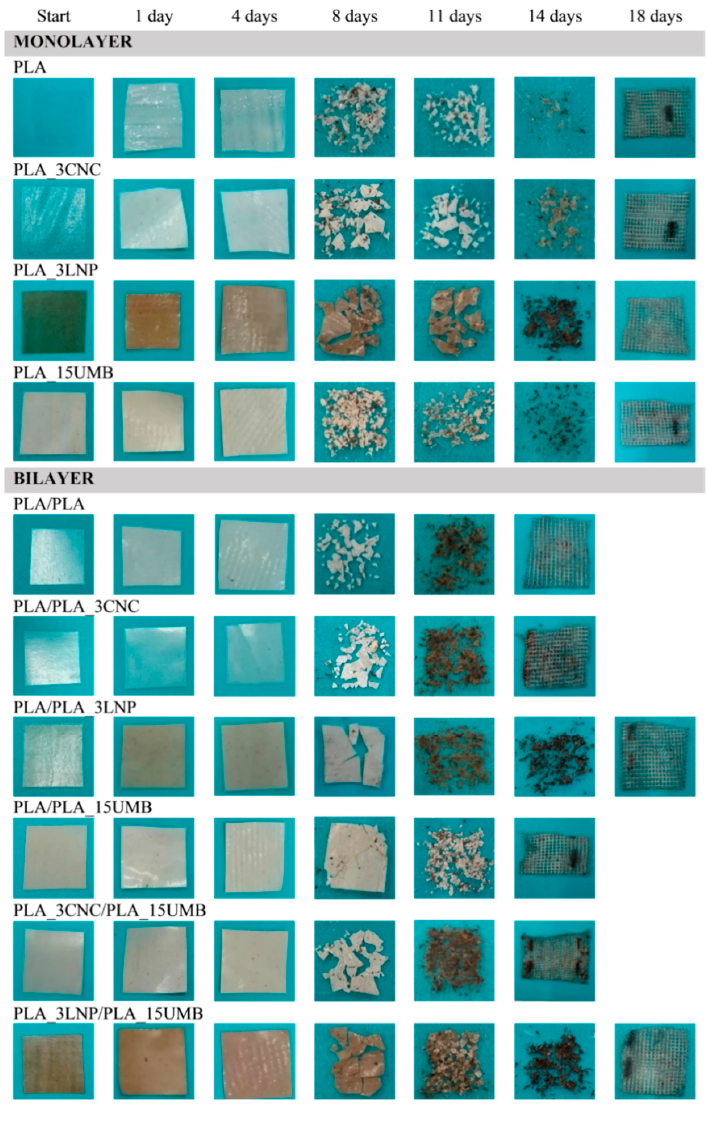
Figure 2. Visual observation of PLA (neat and nanocomposites) monolayer and bilayer films at different stages of incubation in composting conditions.